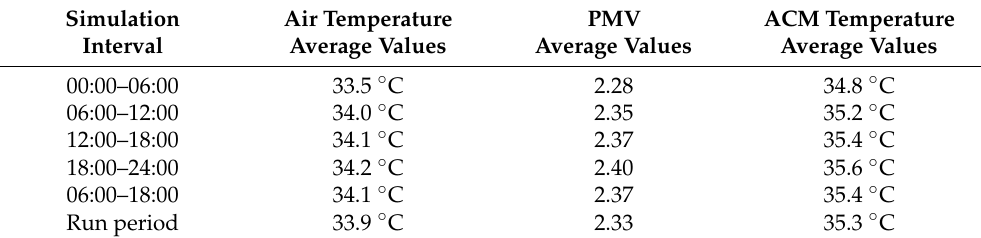
Table 6. Indoor environmental analysis data for the Ponticelli building. Simulation